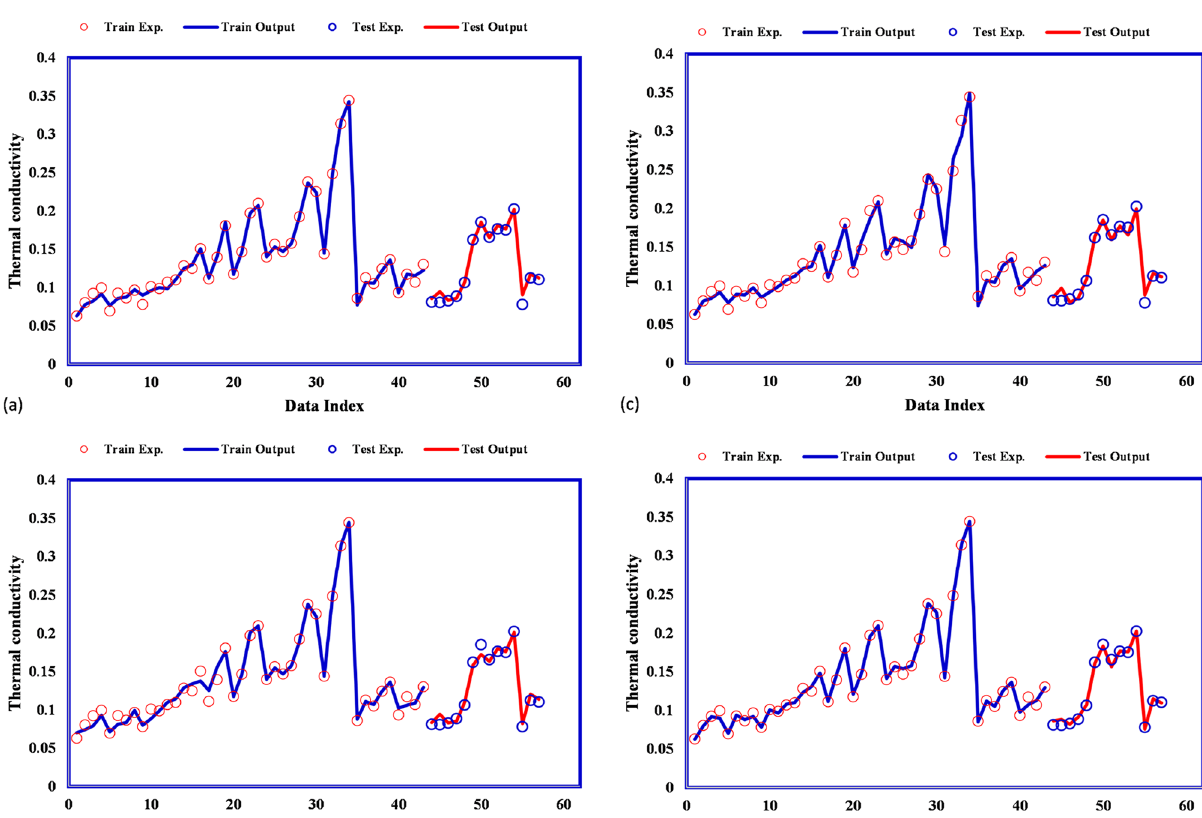
Figure 5. Comparison of model outputs and experimental values for ( a ) exponential, ( b ) squared exponential, ( c ) rational quadratic, ( d )